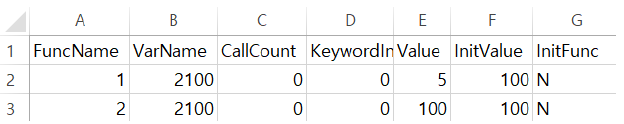
Figure 8. Variable vulnerability detection training module and variable vulnerability detection module.